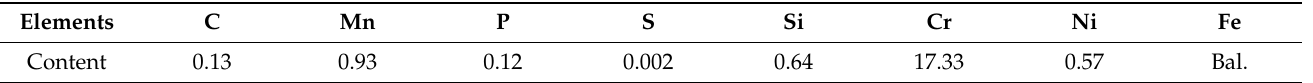
Table 1. Chemical composition of AISI 430 ferritic stainless steel (wt.%).